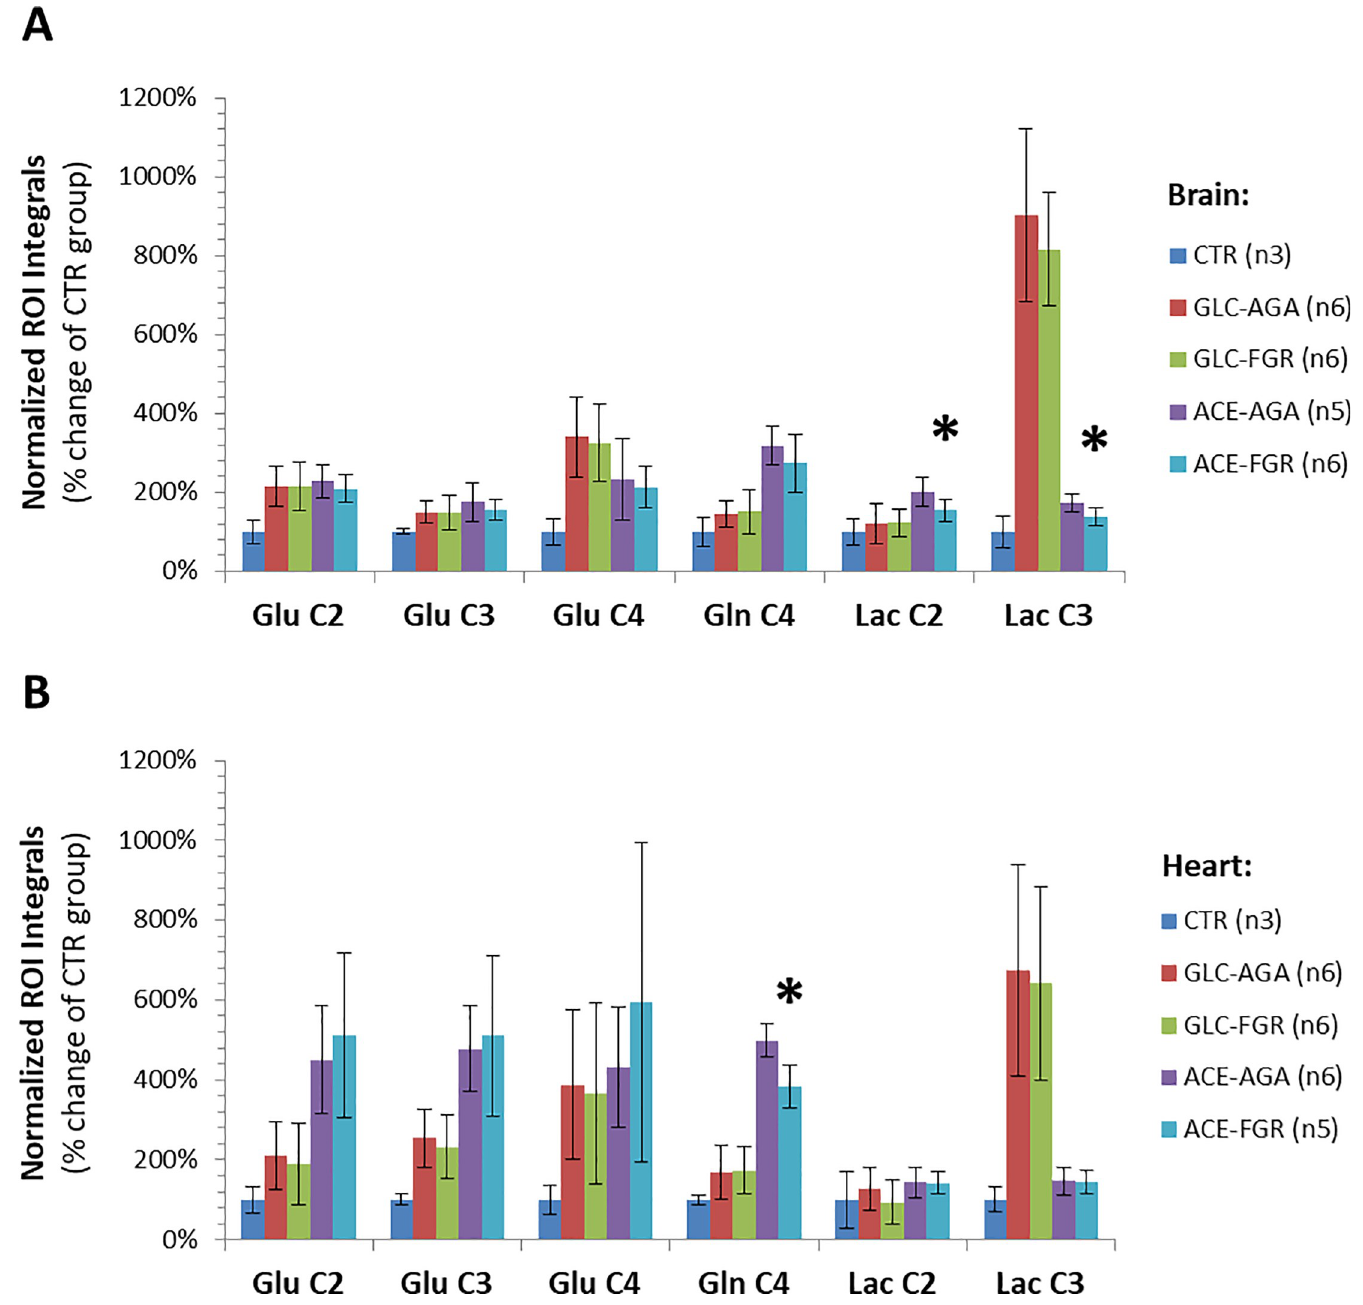
Fig 2. Quantification of 13 C-enriched metabolite levels based on 2D 1 H- 13 C HSQC spectra for different tissue samples and experimental groups. Values are displayed as normalized ROI integrals (average ± SD) for brain ( A ) and heart ( B ) samples of GLC and ACE groups, referenced to the CTR group (natural abundance of 13 C, i.e. 1.1%). Metabolite labels as detailed in Fig 1 legend. Significant differences between AGA and FGR subjects are indicated ( � p < 0.05, two-tailed unpaired t-Test).